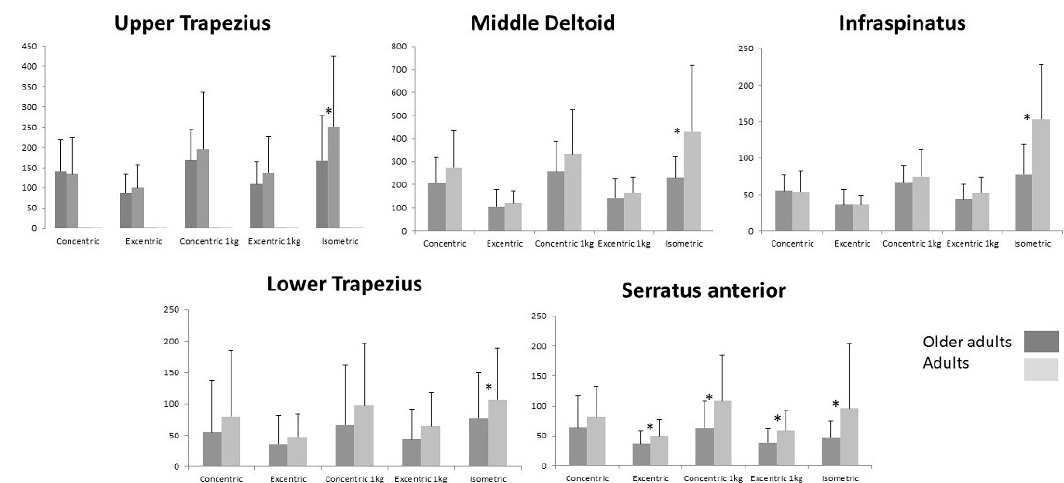
Figure 3. Means (standard deviation) of RMS for each muscle are shown for every muscle contraction: dynamics (concentric and eccentric; with and without 1 kg resistance) and isometric. * p < 0.05 between age groups.